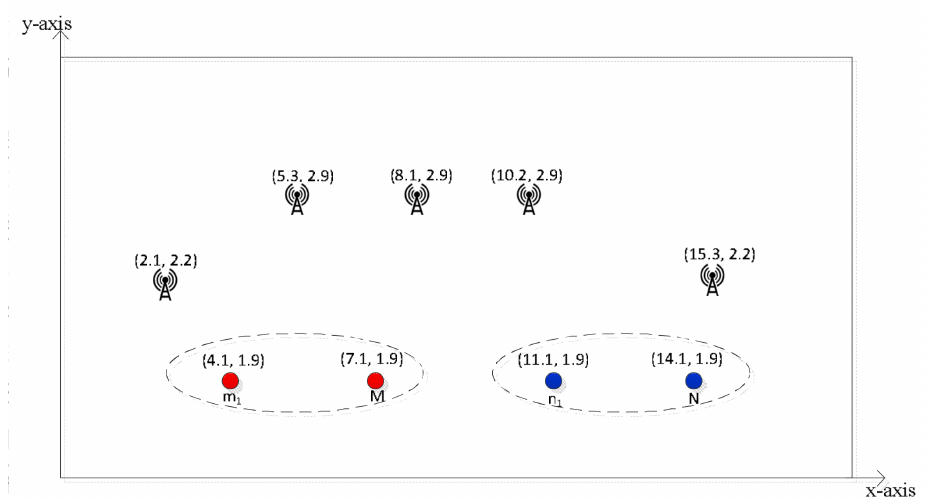
Figure 3. Example of a network